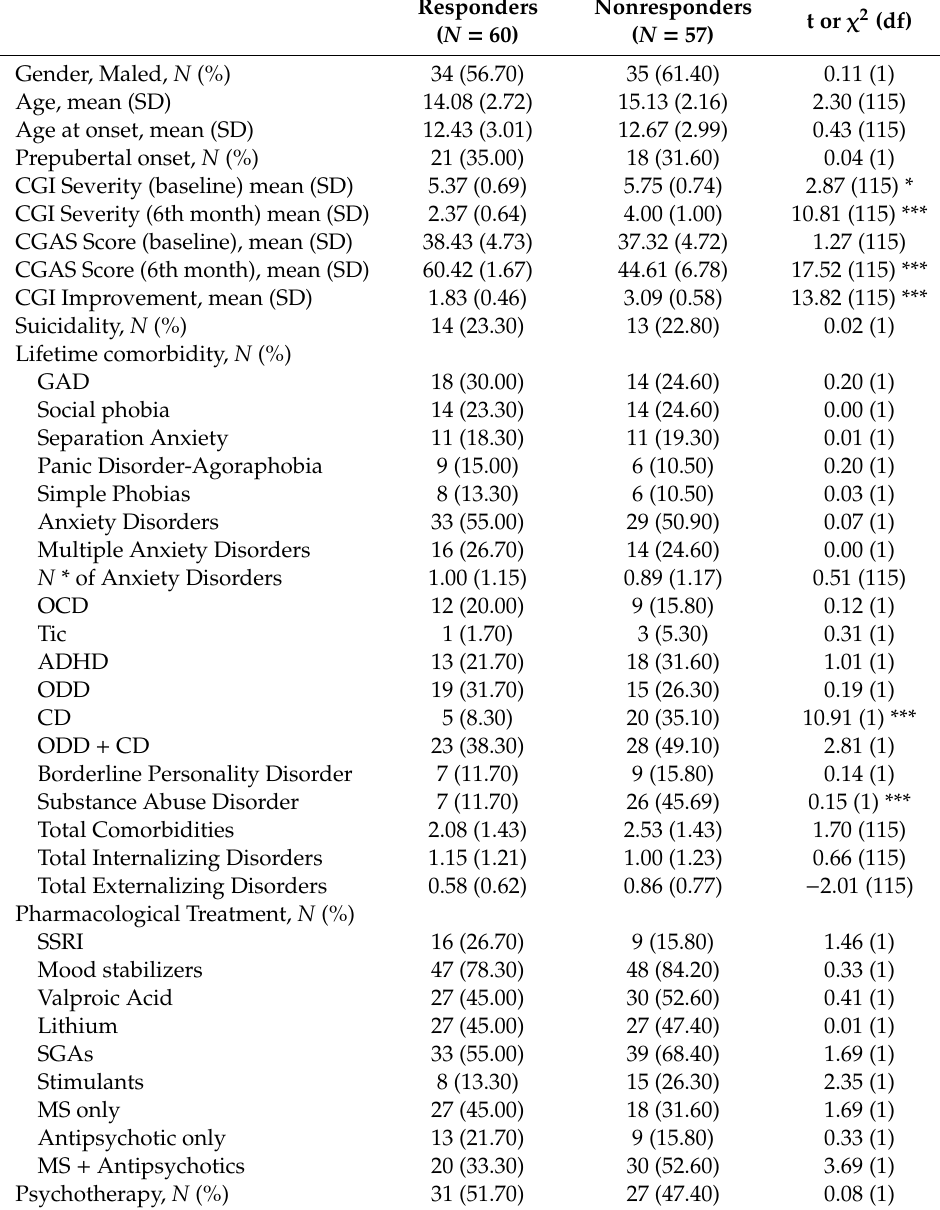
Table 6. Comparison between patients responders ( N = 60) and nonresponders ( N = 57).